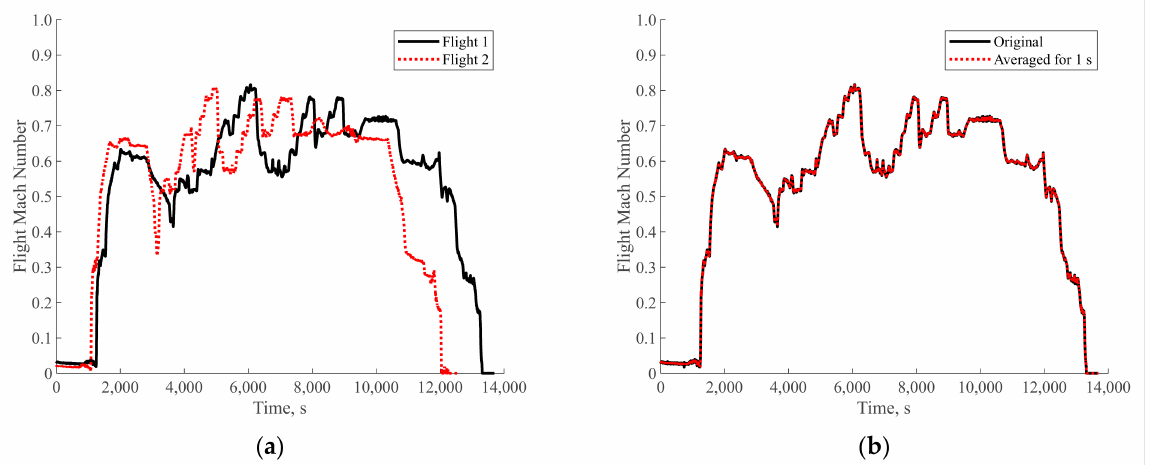
Figure 4. Representative flight history showing Mach number: ( a ) Original flight histories for two flights; ( b ) original and 1-s-averaged flight histories for the smooth